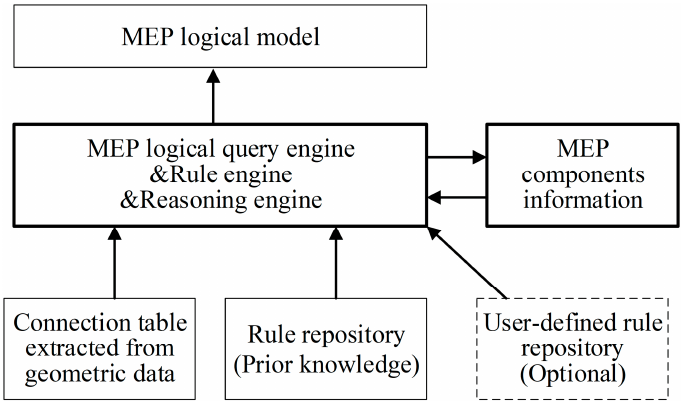
Figure 8. The workflow of logical relationships completion of MEP model.